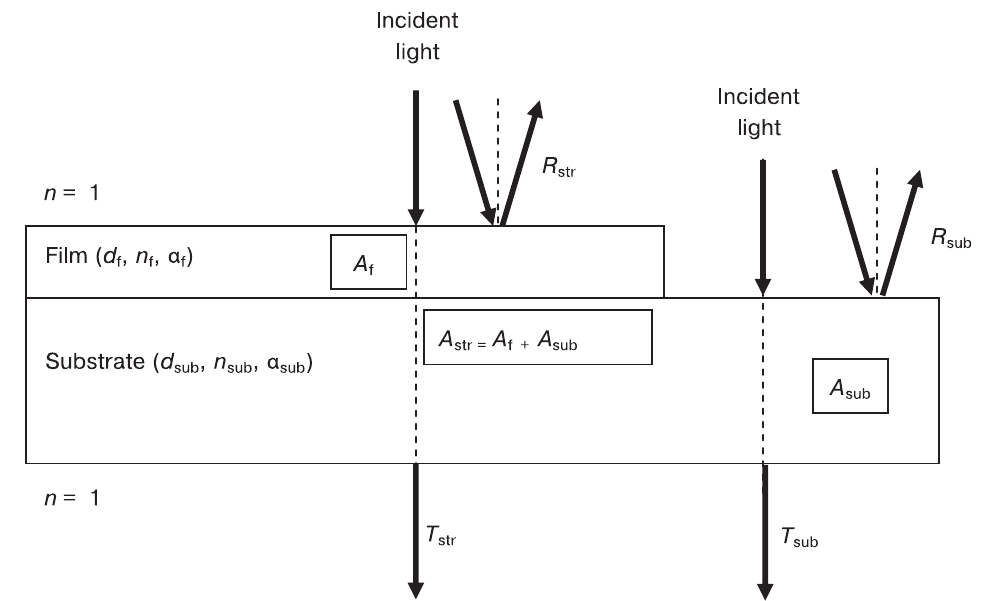
Figure 1. Model of a single-layer structure (film on substrate) and light interaction schematic.